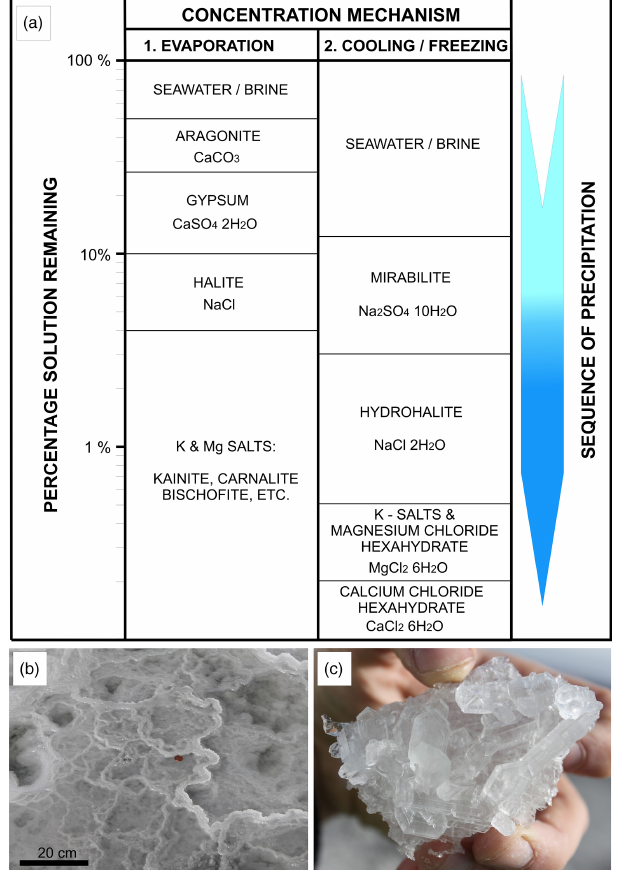
Figure 4. (a) Mineral precipitation sequences from seawater de- pending on the concentration mechanism. Arrow shows the sense of precipitation. Left scale (logarithmic) shows the percentage of remaining brine during the concentration process. Evaporative con- centration sequence defined by Orti (2010) and frigid concentra- tion by Dort and Dort (1969). (b) and (c) : mirabilite precipitation in a pond near a Na 2 SO 4 -rich water spring in Belorado (Burgos, Spain). Photographs taken early in the morning after 3 days of con- tinuous cool temperatures (30 November 2011). General view of the mirabilite pond (b) . See coin as scale (diameter 1.8cm).